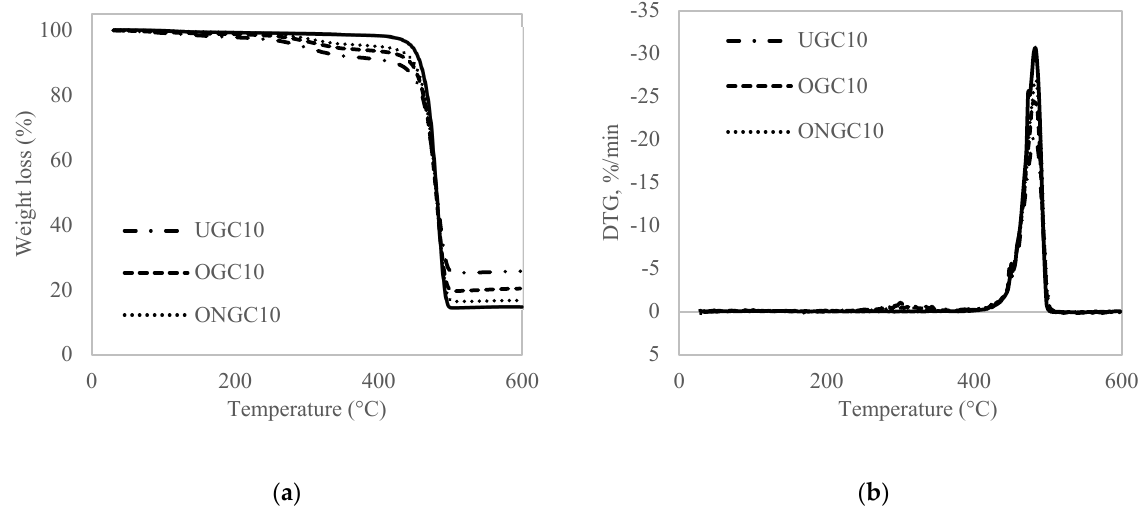
Figure 3. ( a ) Thermogravimetric analysis (TGA) thermogram; and ( b ) Differential thermogravimetric